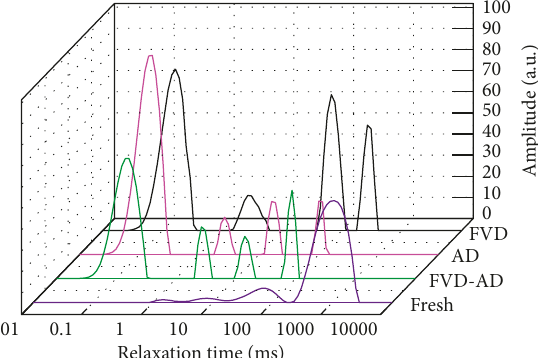
Figure 3: LF-NMR T 2 relaxation time distribution curves of samples. FVD: freeze vacuum drying; AD: air drying; FVD-AD: combined drying consisting of vacuum freeze drying and air